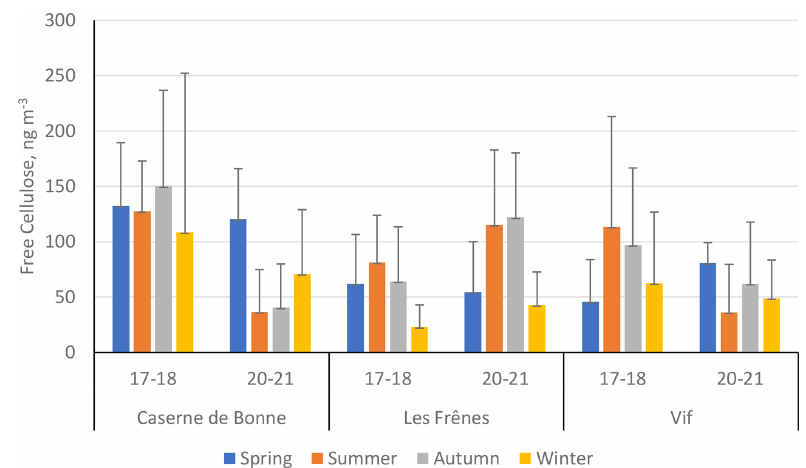
Figure 6. Seasonal mean averages of cellulose concentrations (ngm − 3 ) of the three sites within the Grenoble metropole across the two separate sampling periods: 2017–2018 (17–18) and 2020–2021 (20–21). Black error bars represent 1 standard deviation of the seasonal means. Only positive error bars are shown to aid clarity. Seasons are defined as December–February (winter), March–May (spring), June– August (summer), and September–November (autumn). Site classifications are as follows: urban for Caserne de Bonne, urban background for Les Frênes, and peri-urban for Vif.